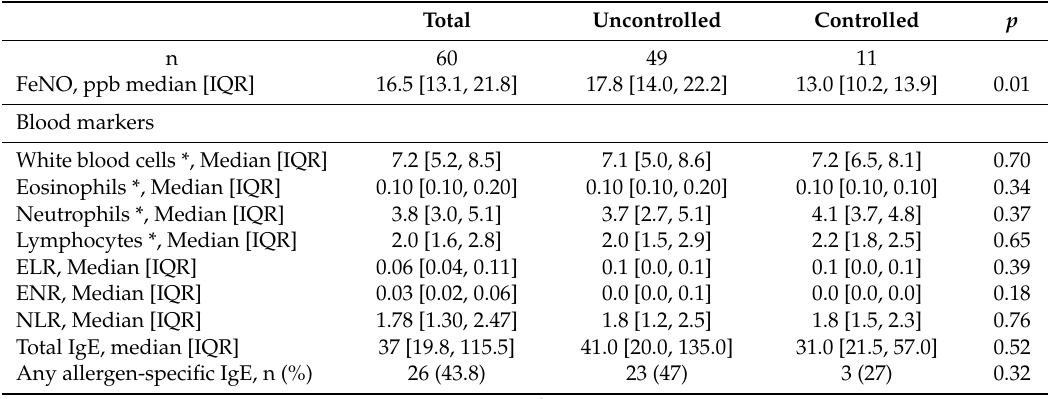
Table 5. Inflammatory markers in Uncontrolled and Controlled